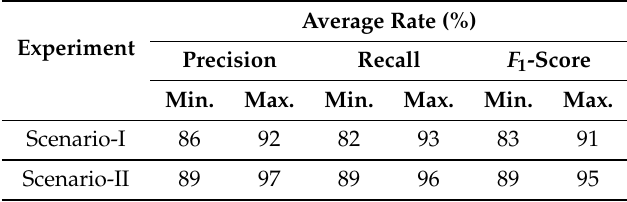
Figure 10. Precision, recall and F-1 score for each activity using GC-S method. Table 2. Overall detection rate of precision, recall and F 1